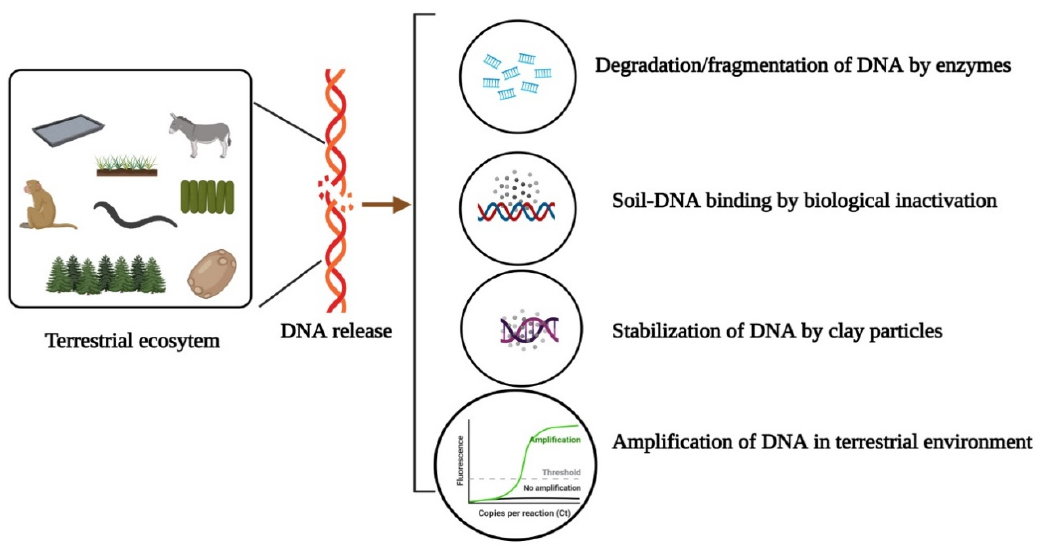
Figure 1. Fate and mobility of DNA in a terrestrial environment.